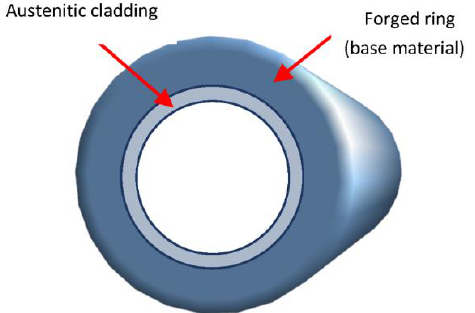
Figure 1. Cutting of the cladded block from a forged ring.